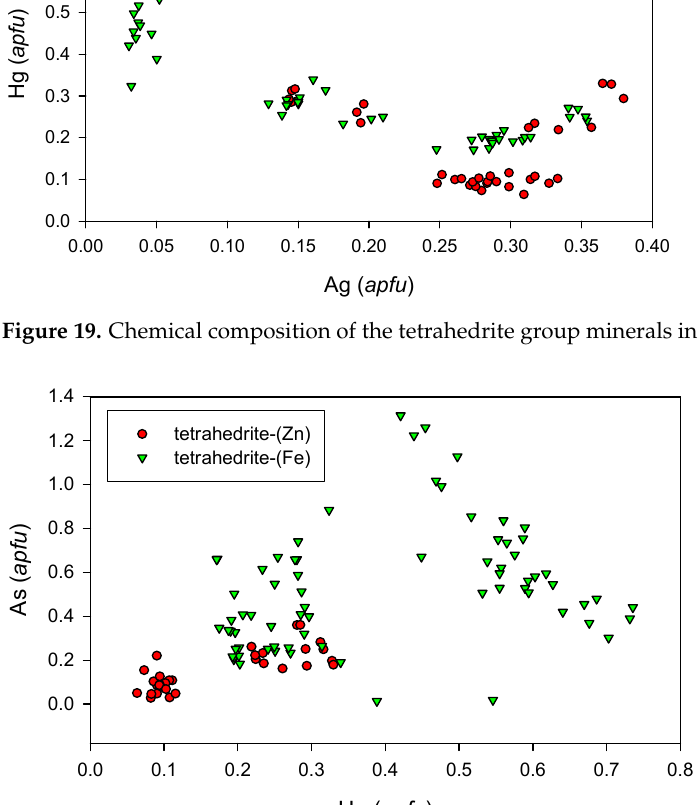
Figure 20. Chemical composition of the tetrahedrite group minerals in the graph Hg vs. As (apfu ).